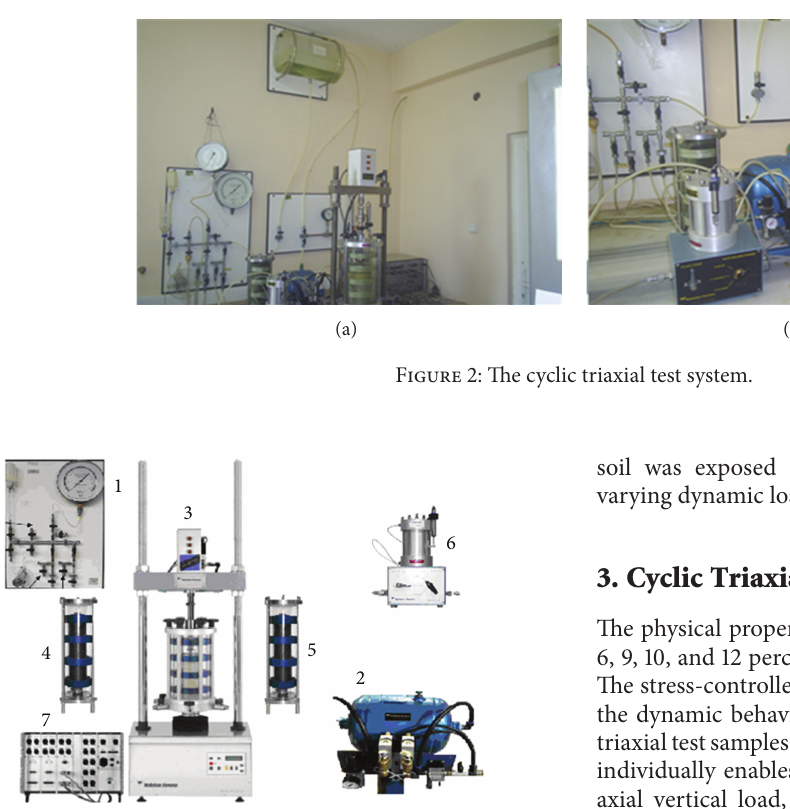
Figure 3: Equipment of cyclic triaxial